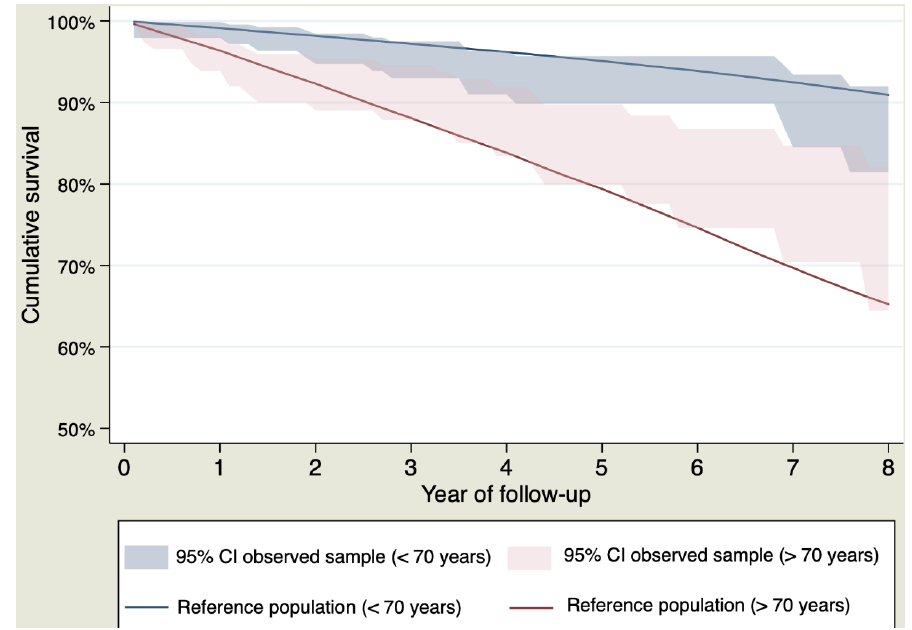
Figure 5. Survival curves stratified by age > or < 70 years for patients who survived the postoperative period.